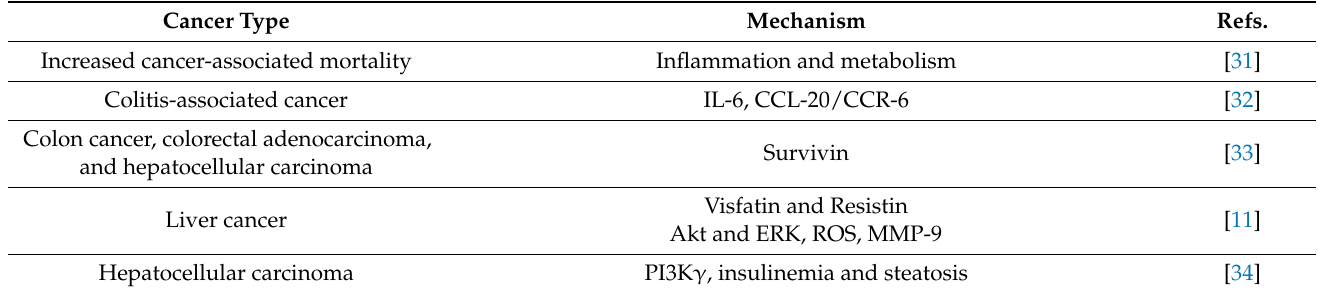
Table 1. Endocrine communication between adipose tissue and the tumor